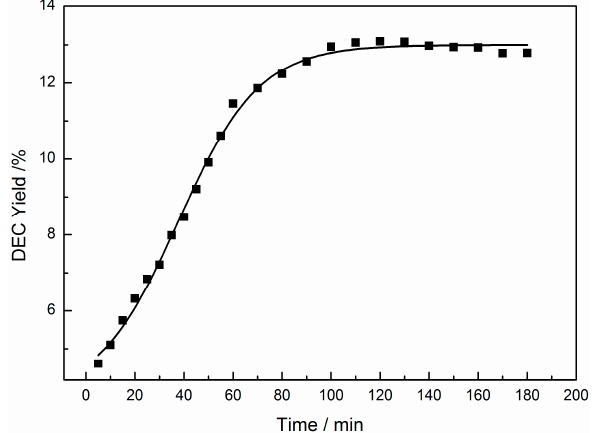
Figure 6. The relationship between the reaction time and yield of DEC at 150 °C for 180 min. (both of the volumes of ethanol and PO were 10 mL; the initial pressure was 5 MPa).